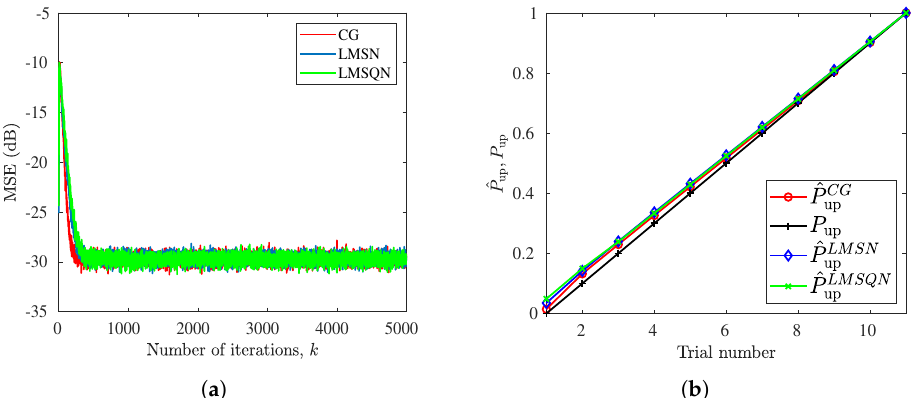
Figure 7. Simulation 3 for fourth-order AR input signal: ( a ) Learning curves for the data selection and ( b ) Comparison between the desired P up and achieved ˆ P LMSN up , ˆ P LMSQN up and ˆ P CG up by the data-selection algorithms. Table 1. Misalignment with outliers, in